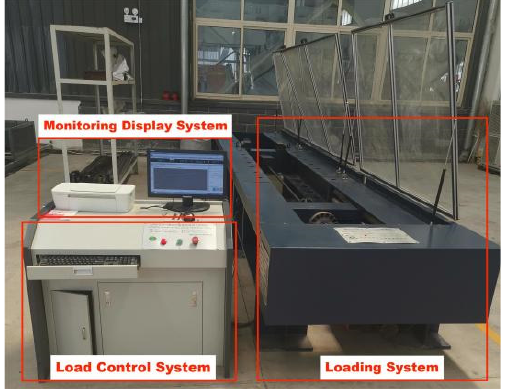
Figure 4. 600 KN anchor static load test system.